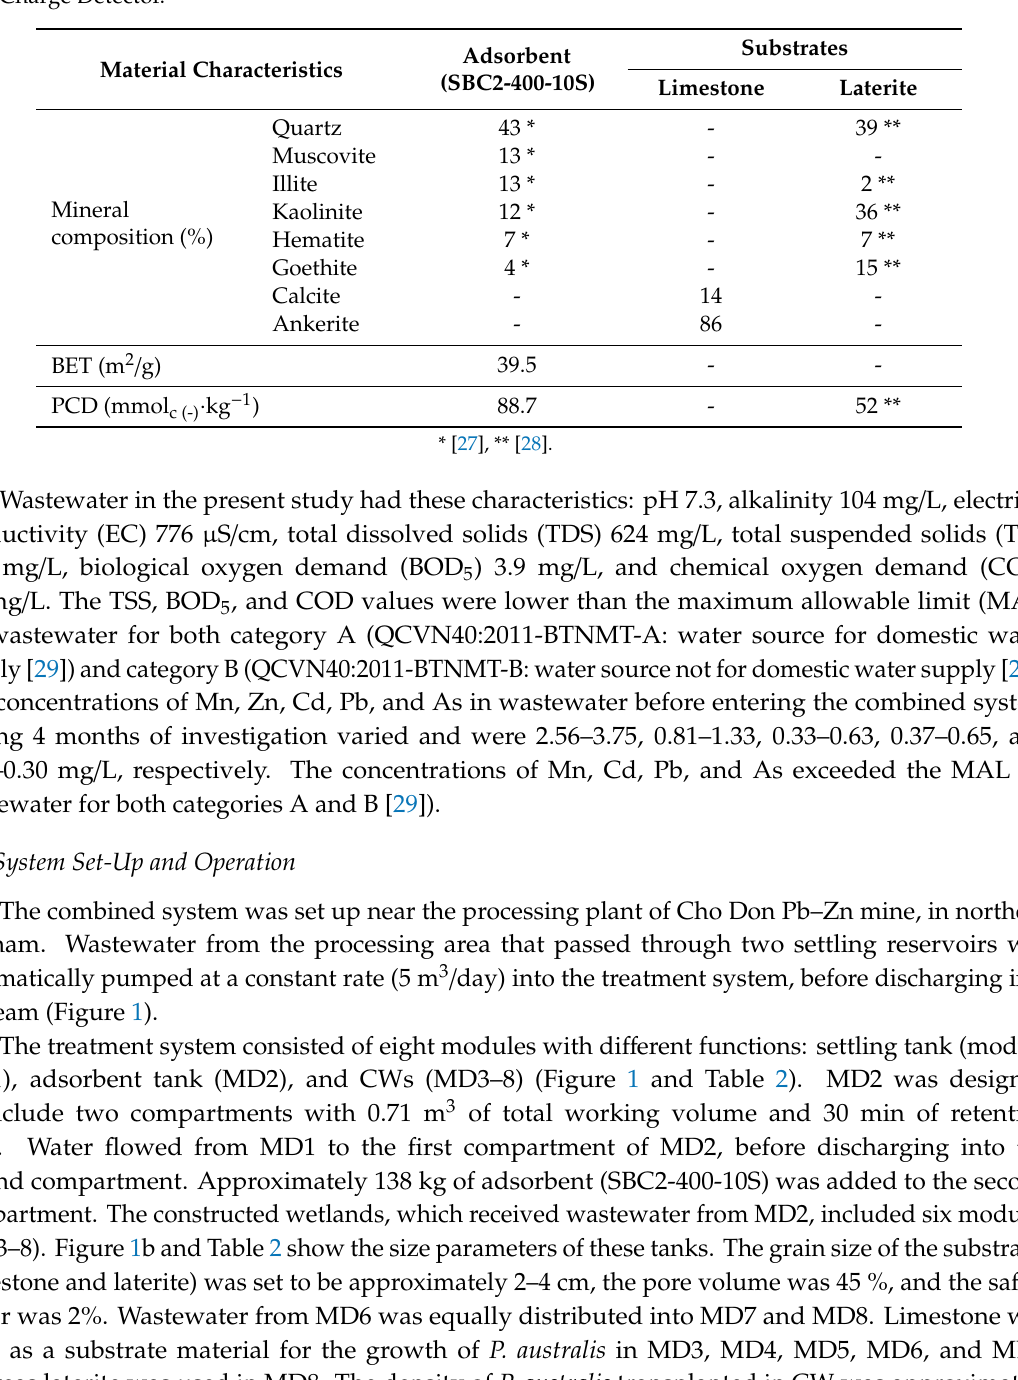
Table 1. Characteristics of adsorbent and substrates. BET: Brunauer–Emmet–Teller, PCD: Particle Charge